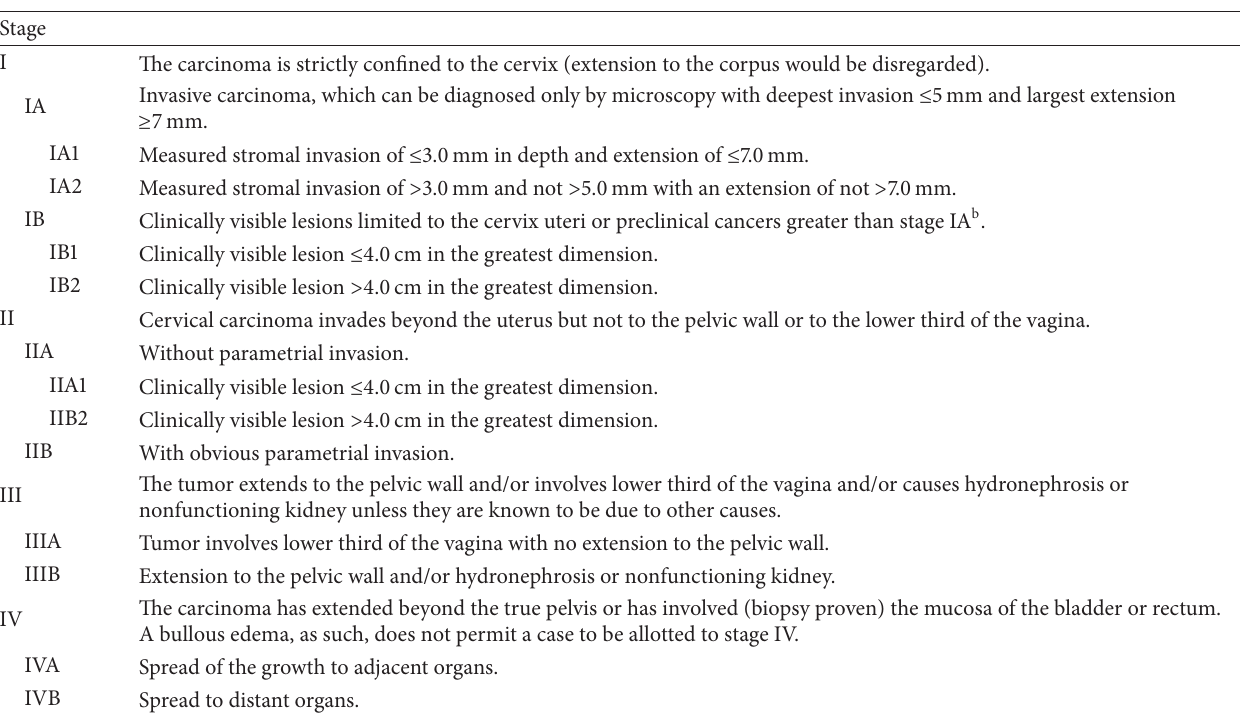
Table 1: Carcinoma of the cervix uteri: F´ederation Internationale de Gyn´ecologie et d’Obst´etrique (FIGO) staging system (adapted from Reference [4]).